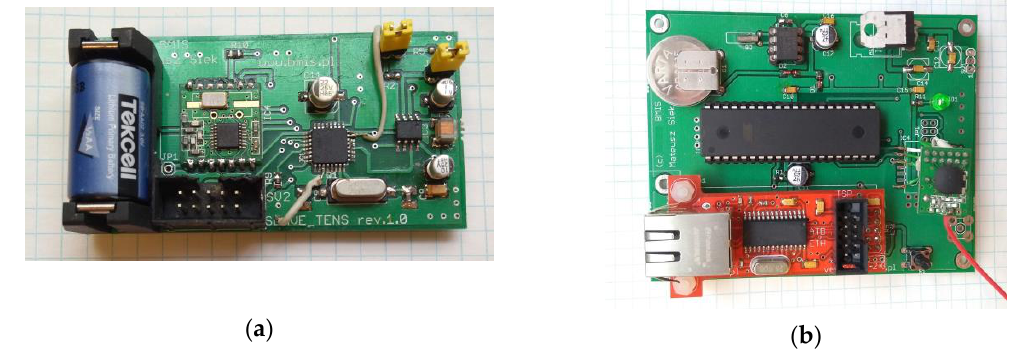
Figure 5. Elements of the system, ( a ) wireless sensor node (dimension 75 × 44 mm), ( b ) access point (dimension 100 × 80 mm).